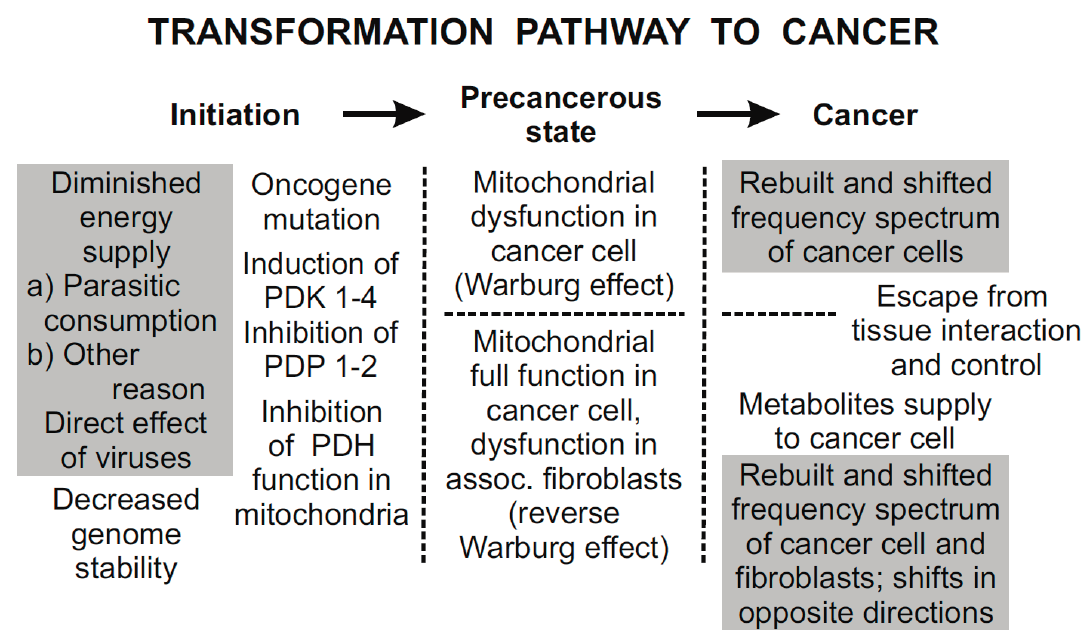
Figure 5. The three principal periods of the transformation pathway to cancer